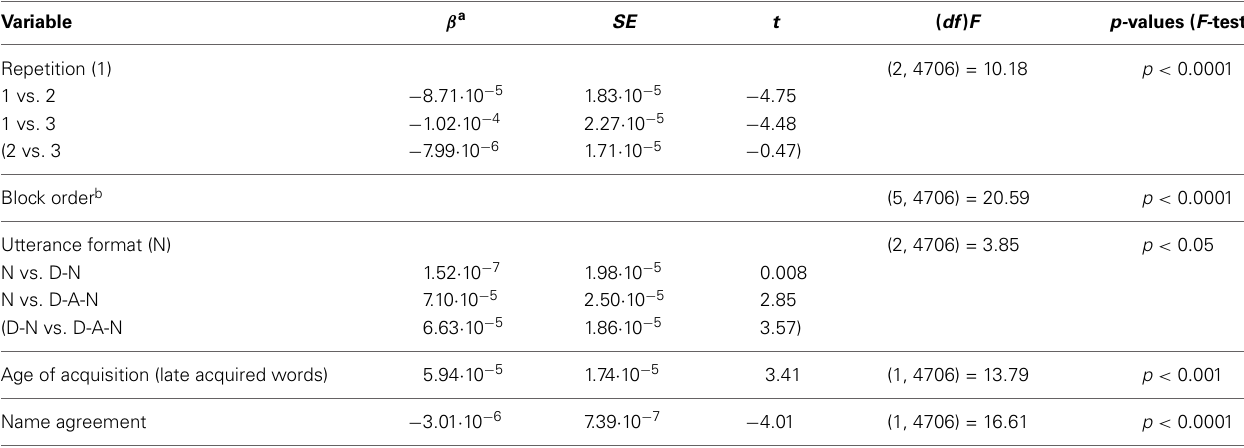
Table 1 | Summary of mixed-effects regression model for response